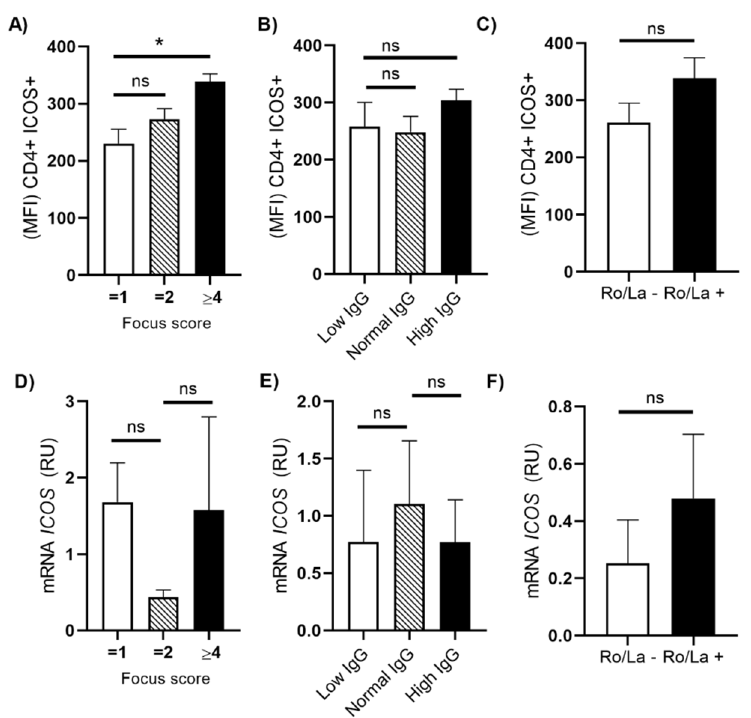
Figure 3. Distribution of ICOS expression in pSS with focus score and antibodies. ( A ) Comparison of ICOS membrane expression (MFI) patients with =1, =2, and 4 ≥ focus score. ( B ) ICOS MFI according to the IgG serum levels (low < 700 mg/dL, normal IgG = 700–1600 mg/dL, and high IgG ≥ 1600 mg/dL). ( C ) (ICOS MFI according to the Ro/La antibodies positive or negative. ( D ) mRNA levels of ICOS according to focus score. ( E ) ICOS mRNA expression according to the IgG serum levels. ( F ) mRNA levels of ICOS according to Ro/La antibodies positive. Quantification of mRNA was performed using real-time PCR and the results are expressed as relative units (RU). The level of significance is represented by * p < 0.05, Kruskal–Wallis test and Mann–Whitney U-test, ns = not signifi- cative.